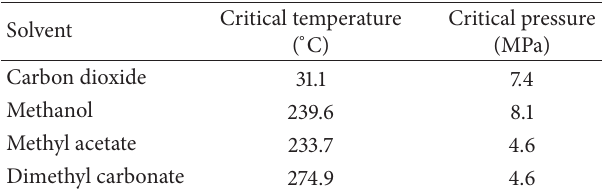
Table 3: The critical properties of various solvents. Critical temperature Critical pressure Solvent ( ∘ C) (MPa) Carbon dioxide 31.1 Methyl acetate Dimethyl carbonate